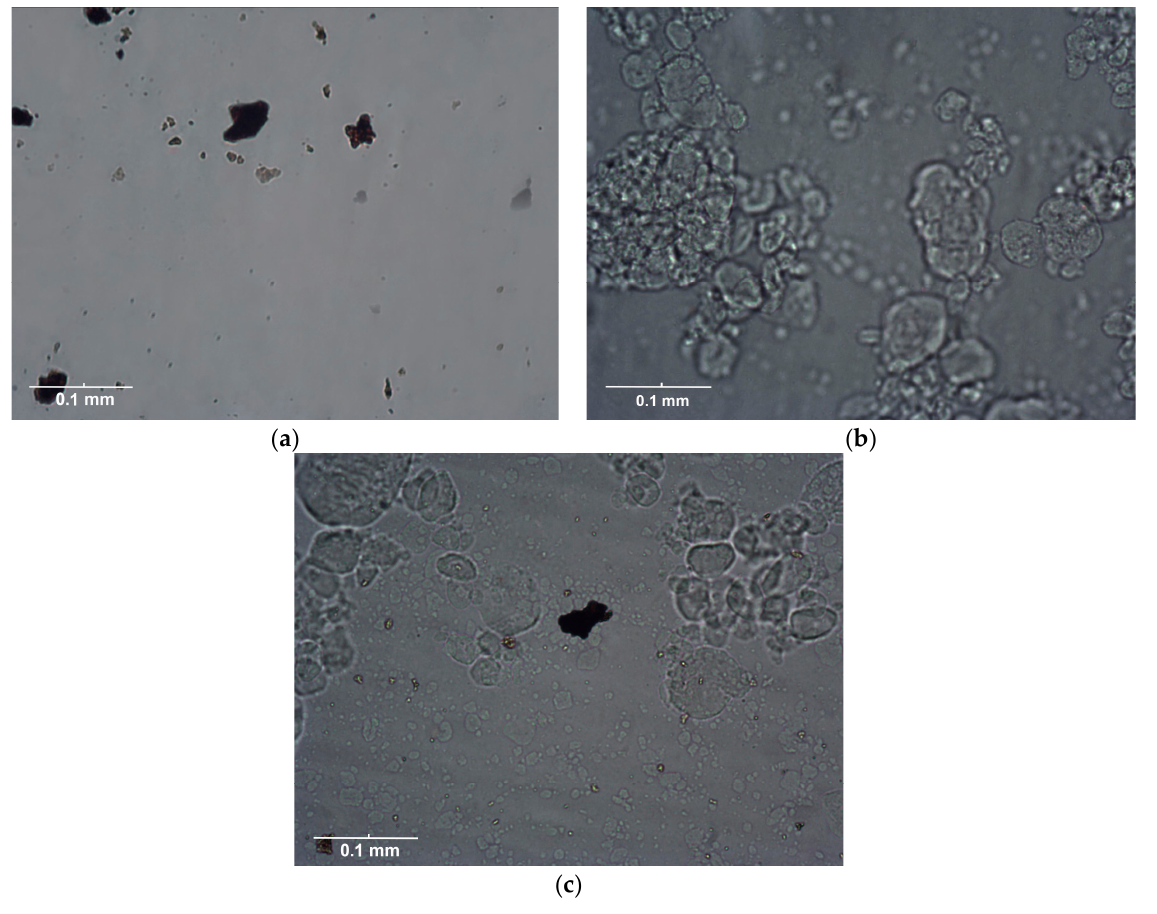
Figure 7. Microscopic images of the solution of ( a ) a humic acid concentration of 150 mg L − 1 , ( b ) a colloidal silica concentration of 1000 mg L − 1 , and ( c ) a mixture of humic acid and colloidal silica before filtration.